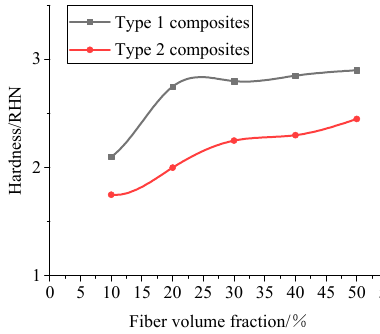
Figure 16. Influence of fiber volume fraction on the hardness of various composites.